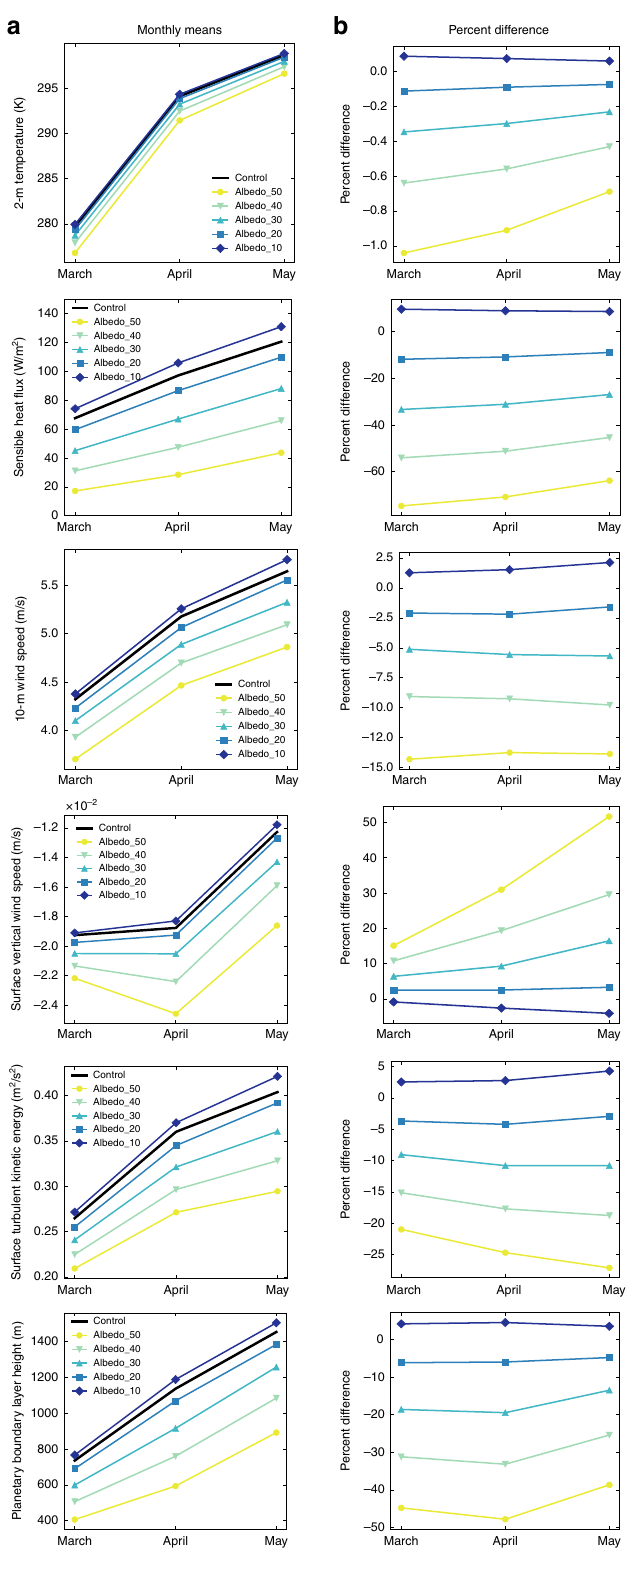
Fig. 3 Monthly means and percent differences of various near-surface variables for the Hami Basin. a Monthly means of corresponding variables for all albedo model runs (lines with markers) and the control run (thick black line) based on Domain 3 output. The values for each month are averaged for the region in which the albedo was altered (black box in 2 b ). b Percent difference from WRF_Control for each albedo simulation as compared with the control simulation. Negative values indicate a lower values in the Albedo_40 simulation compared with WRF_Control, while positive values indicate